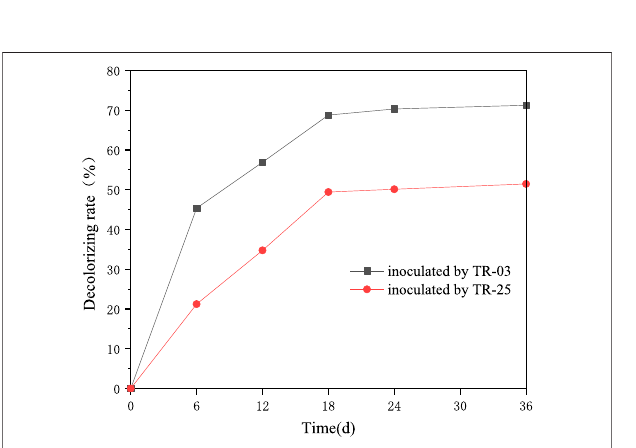
FIGURE 2 | Evolutionary relationships and phylogenetic trees based on 16S rDNA sequence of TR-03 and TR-25.